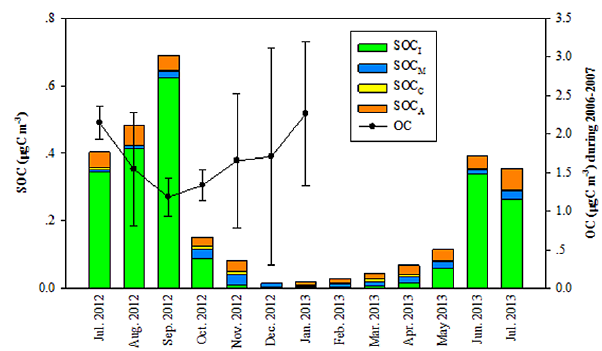
Figure 10. Seasonal variations of estimated SOC. OC data at the NC site during July 2006 to January 2007 were reported by Ming et al. (2010) and the error bar means one standard deviation in each